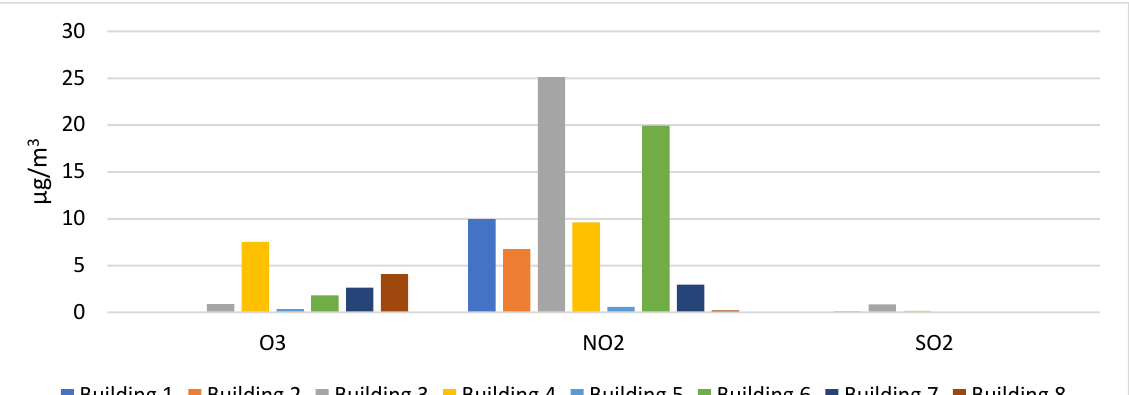
Figure 11. Indoor concentrations (μg m −3 ) of O 3 , NO 2 and SO 2 . As a first evaluation, the computed median and mean values of pollutant concentra- tions of this study were compared with the relevant seasonal (summer) values reported in the OFFICAIR project [17], a European project in which a wide scale of indoor air pol- lutants measurements in 37 office buildings were performed [58]. Overall, among the VOCs, benzene, toluene, and d-limonene concentrations were higher in the investigated buildings compared to OFFICAIR corresponding values (1.4, 8.1 and 4.7 µ g m − 3 respectively) while ethylbenzene (1.8 µ g m − 3 ), a-pinene (4.2 µ g m − 3 ) were of the same level. Aldehydes, formaldehyde, and acetaldehyde concentrations were higher, benzaldehyde was of the same order of magnitude while propionaldehyde, hexaldehyde and acrolein were present in lower levels. In addition, lower concentrations were observed for ozone and nitrogen dioxide. In another large-scale study in European countries, VOC measurements took place in 56 offices buildings [59]. The reported concentrations of benzene (14.6 µ g m − 3 ), toluene (35.1 µ g m − 3 ), d-limonene (34.6 µ g m − 3 ), Benzaldehyde (4.1 µ g m − 3 ), o-xylene (10.2 µ g m − 3 ) and p,m-xylene (22.2 µ g m − 3 ) were much higher than the present results. Regarding the concentrations levels of ethylbenzene, o-xylene and p,m-xylene were of the same magnitude as a recent study conducted in office rooms in Poland; on the other hand, benzene concentrations were higher